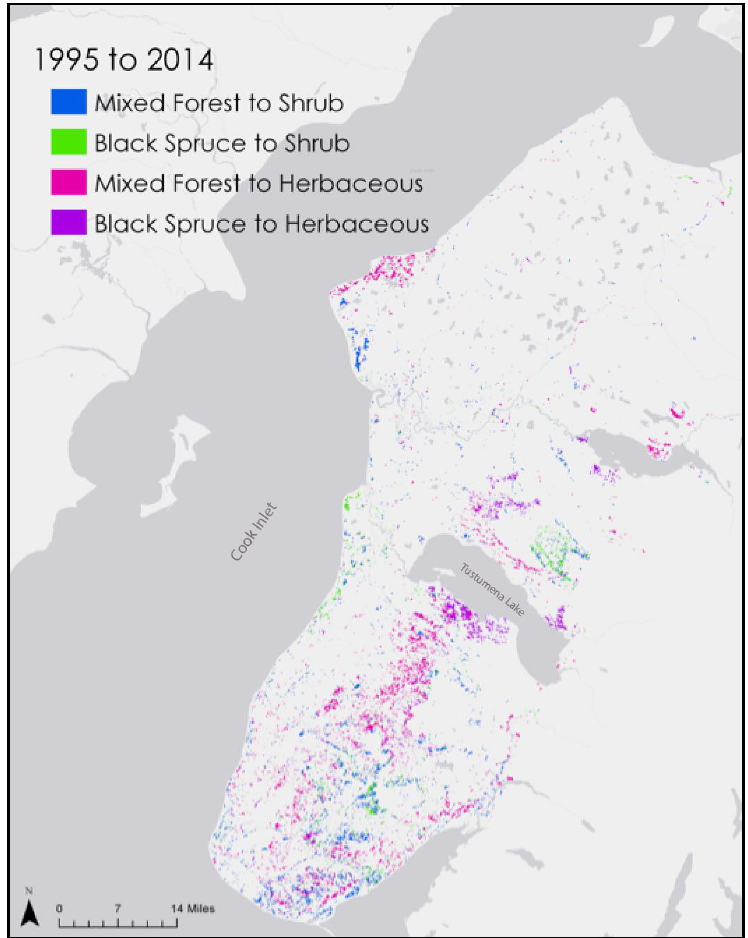
Figure 3. Pixels that changed from forest to herbaceous or shrubland land cover based on classifications of Landsat imagery from 1995 and